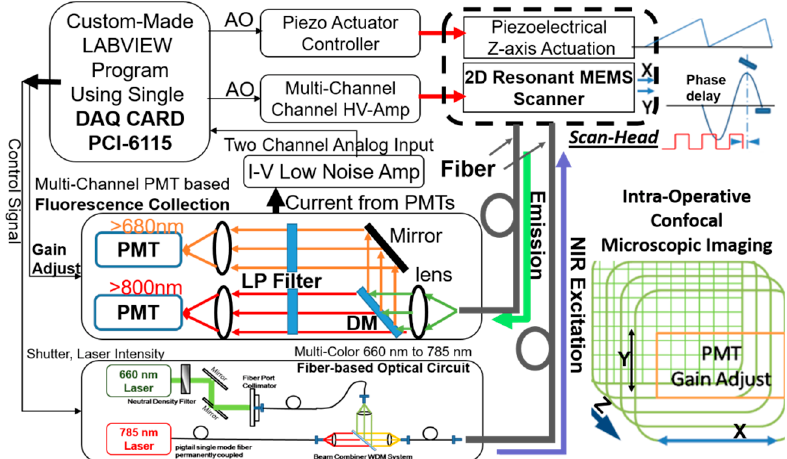
Figure 9. Schematic drawing of the NIR fluorescence confocal imaging system, including the fiber-based multi-color laser excitation and multi-channel fluorescence emission collection system based on photomultiplier tubes (PMT), control system, signal amplification, data acquisition, and real-time image reconstruction; the gain settings of the PMTs were adjusted along the Z -axis for depth imaging. Note: LP filter: long-pass filter, DM: dichroic mirror.